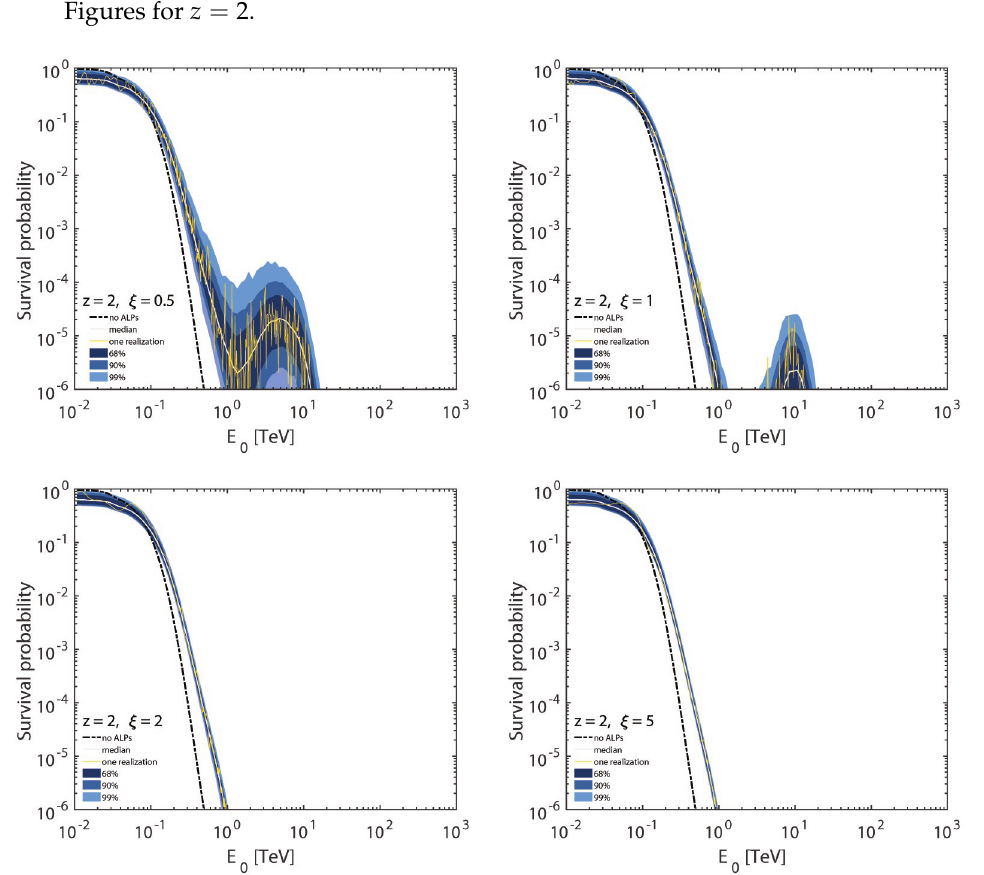
Figure 23. Same as Figure 17 apart from z = 2. (Credit